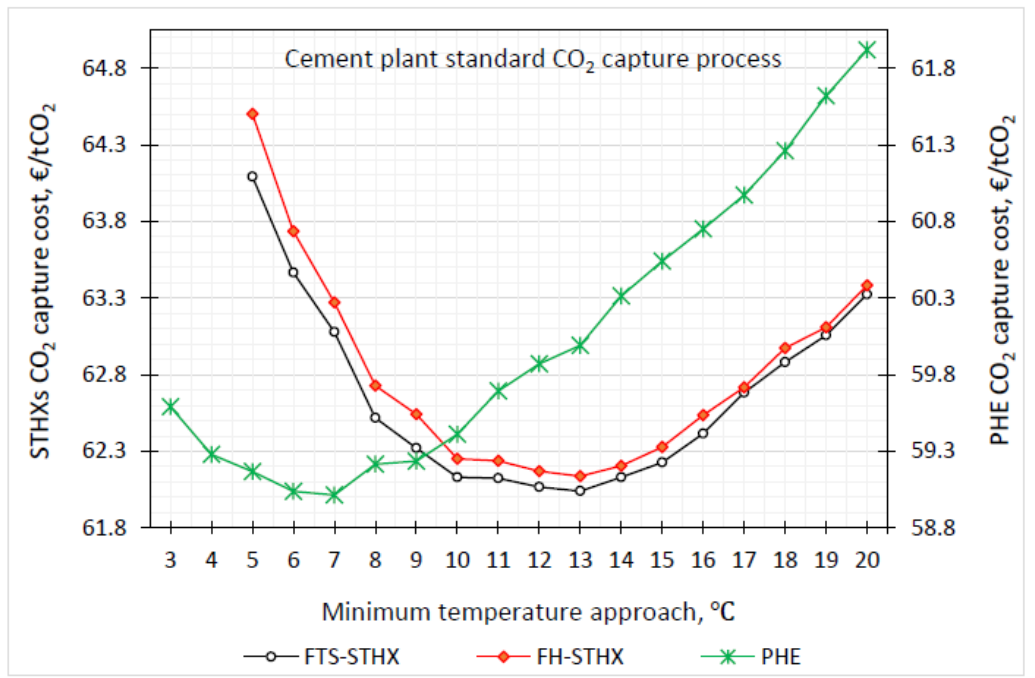
Figure 9. Energy and heat exchanger costs trade-off analysis at different ∆ T min for different heat exchanger types in a standard CO 2 capture from cement flue gas.